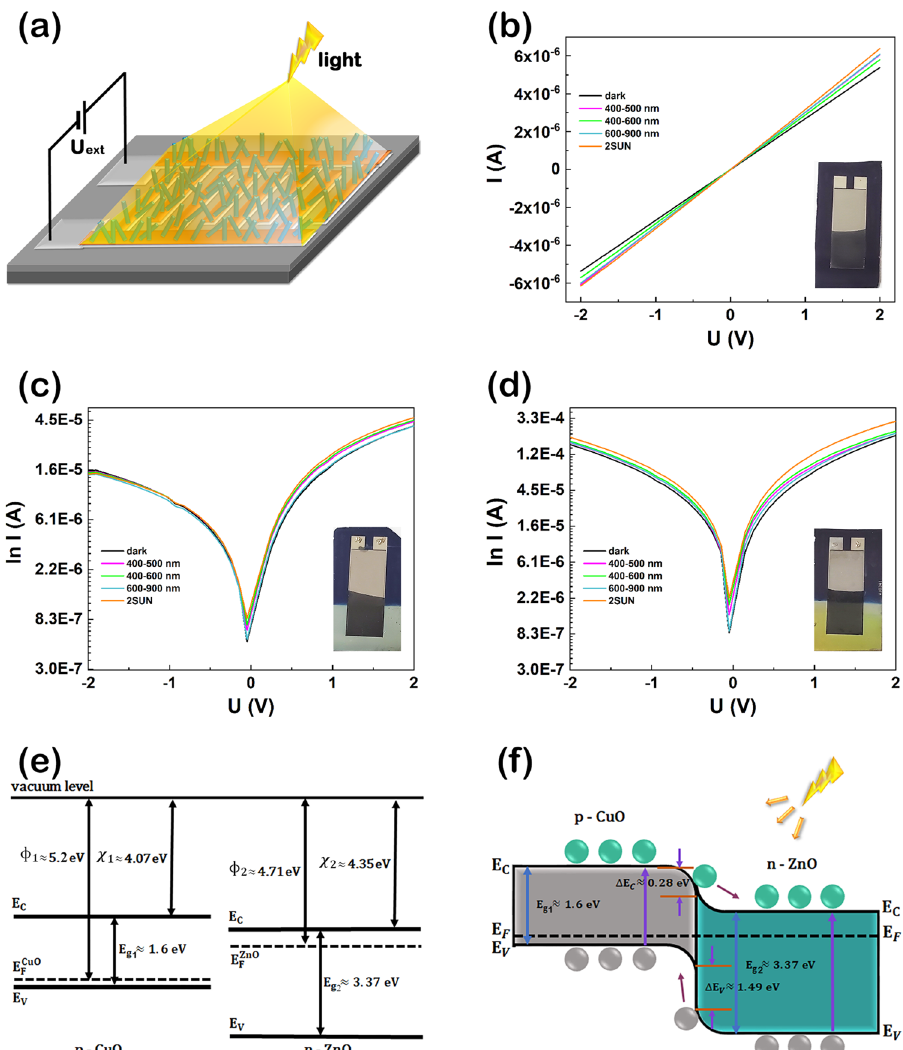
Figure 8. ( a ) Schematic representation of the photodetector system based on self-connected CuO–ZnO core– shell heterojunction nanowire arrays under illumination, ( b ) Current–voltage characteristic of CuO_MIE, I–U semilogarithmic plot of the photodetector systems: ( c ) CuO–ZnO_MIE_1 and ( d ) CuO–ZnO_MIE_2 under dark (black) and under illumination with different spectral intervals: 400–500 nm (magenta), 400–600 nm (green), 600–900 nm (cyan) and 2 SUN (orange), Schematic representations of the band diagrams for: ( e ) CuO and ZnO and ( f ) CuO–ZnO core–shell heterojunction. Insets: ( b–d ) Optical images of the investigated